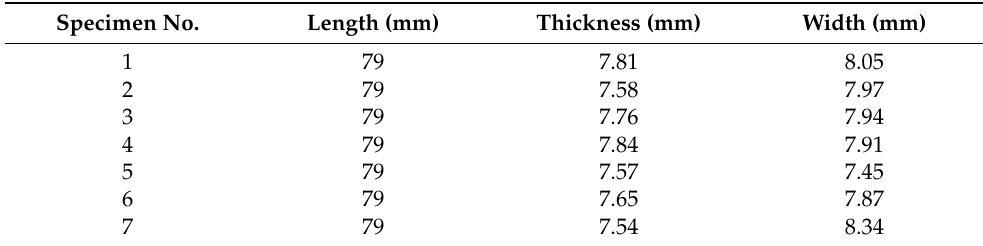
Table 2. Dimensions of samples after